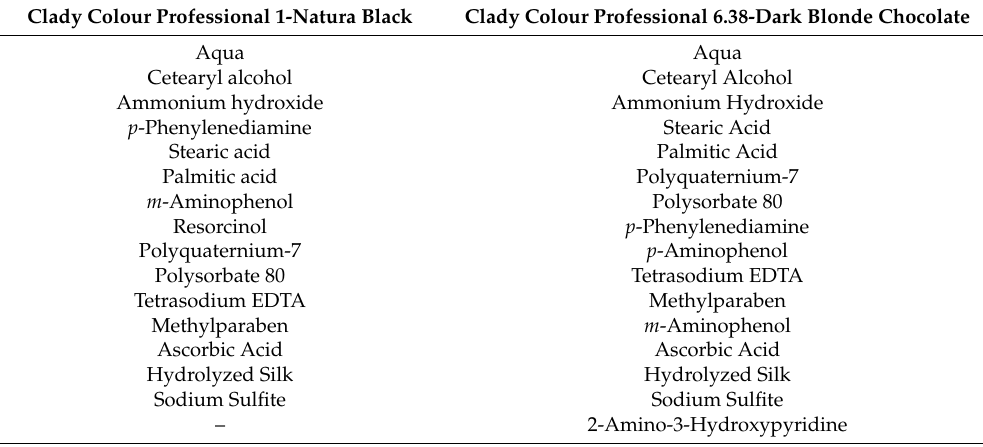
Table 1. International nomenclature of cosmetic ingredients of the hair